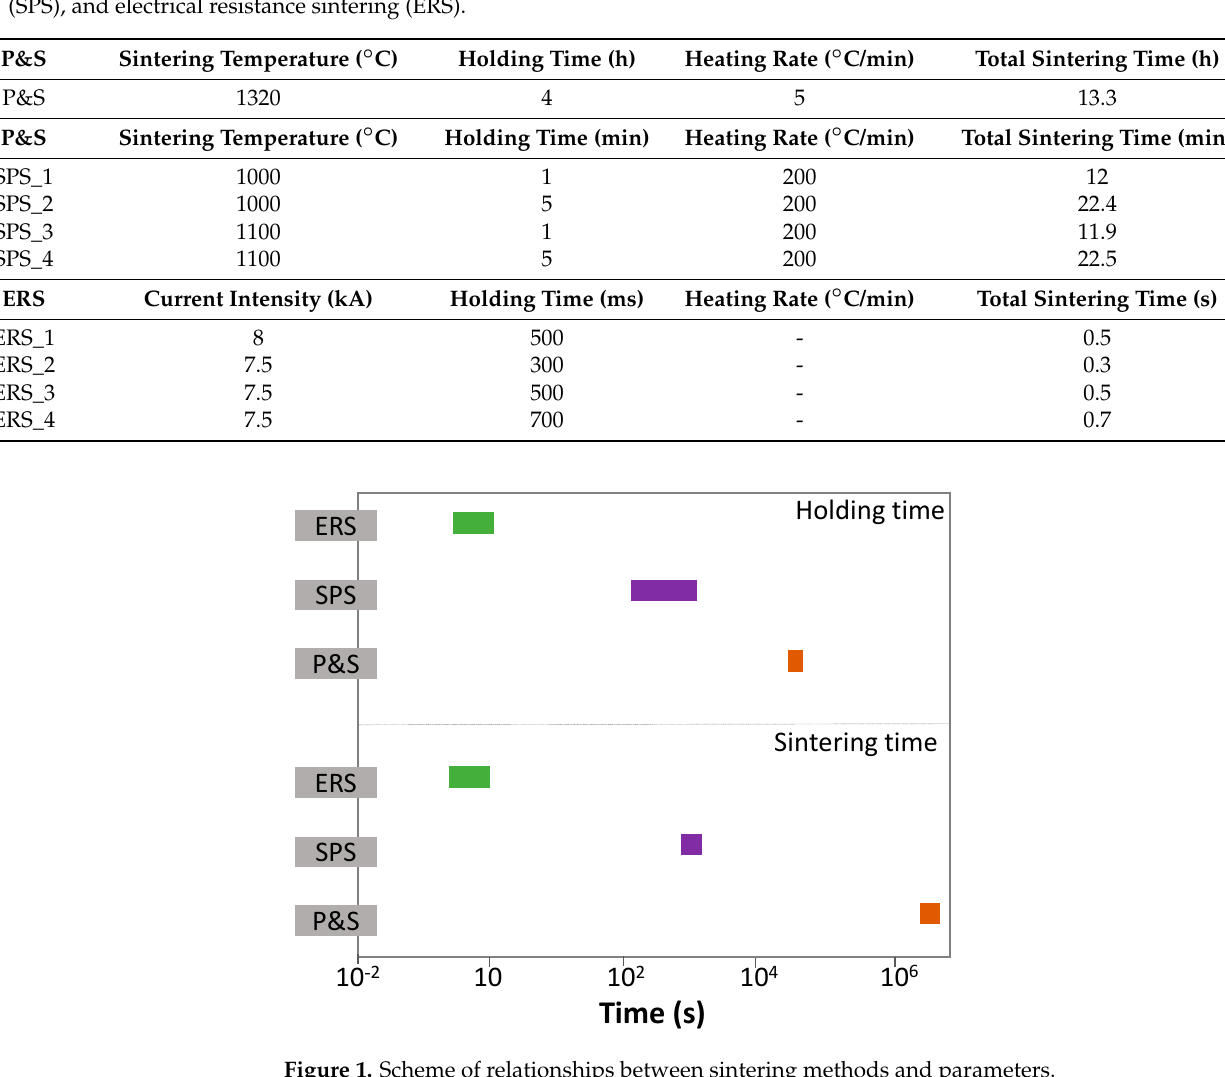
Figure 1. Scheme of relationships between sintering methods and parameters.